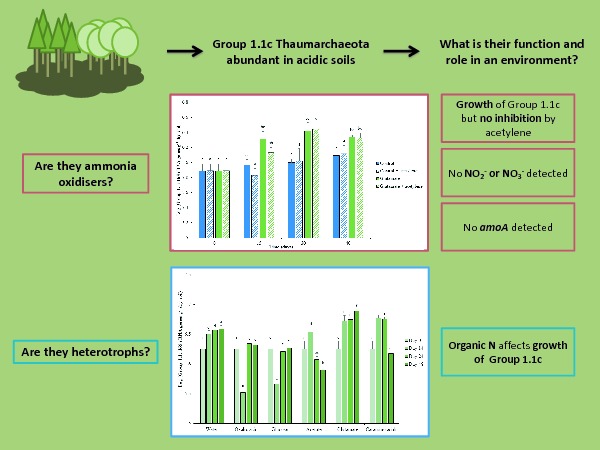
Uncultivated soil Group 1.1c Thaumarchaeota are abundant, but have no known function. We report their growth without ammonia oxidation, unlike thaumarchaeal relatives, and stimulation by organic C.